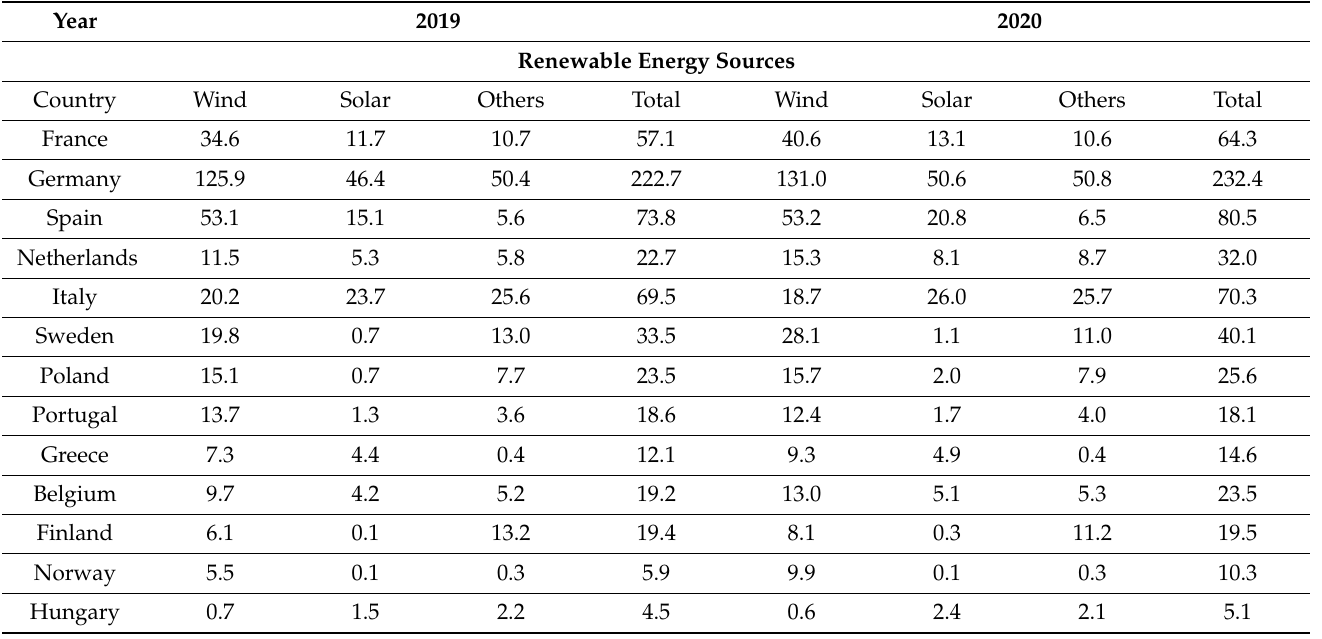
Table 3. EU renewable energy generation 2019 and 2020.